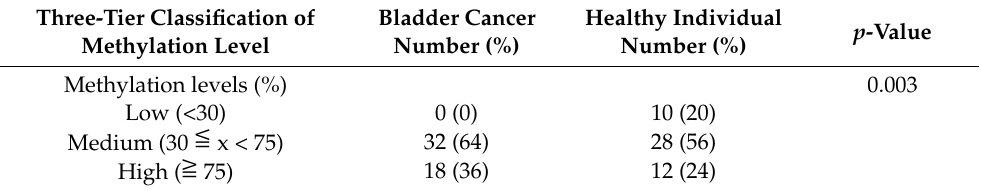
Table 2. Comparison of the sex differences between groups and GSTM5 DNA methylation levels. Table 3. GSTM5 gene methylation levels of 50 patients with bladder cancer and 50 healthy individuals. The methylation level is divided into 3 classes (low, medium and high).